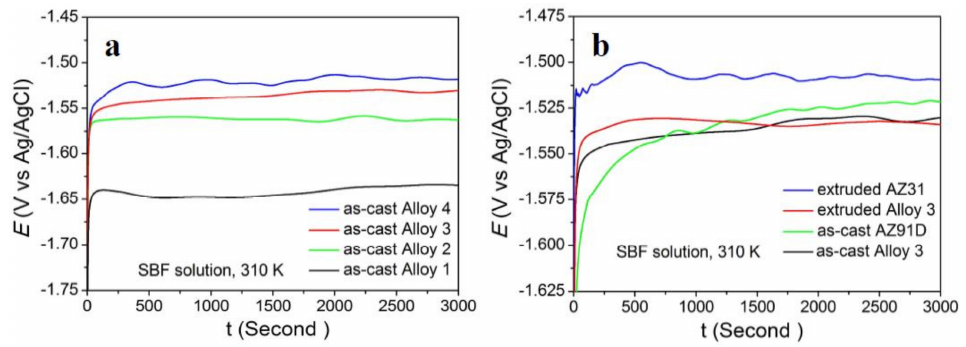
Figure 7. Open circuit potential (OCP) curves of different alloys in SBF (simulated body fluid) solution: ( a ) as-cast Mg (100 − 7x) Zn 6x Y x alloys; ( b ) Alloy 3 and contrast